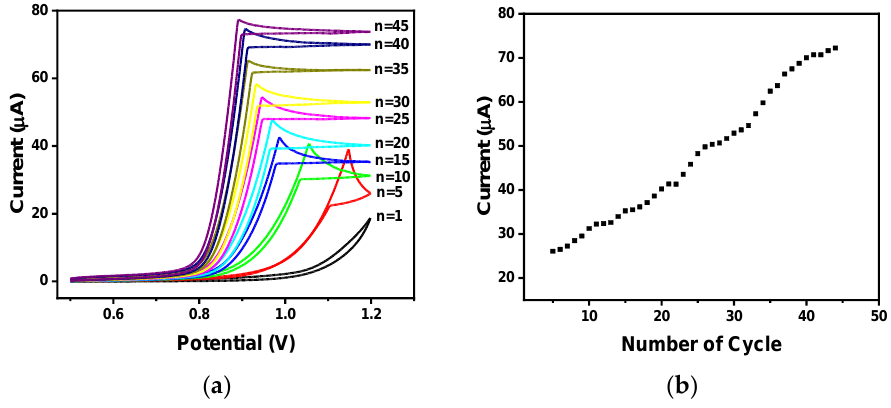
Figure 3. The amination of carbon electrode with 0.5 M ammonium carbamate. ( a ) CV voltammogram and ( b ) its maximal oxidation currents by cycles.